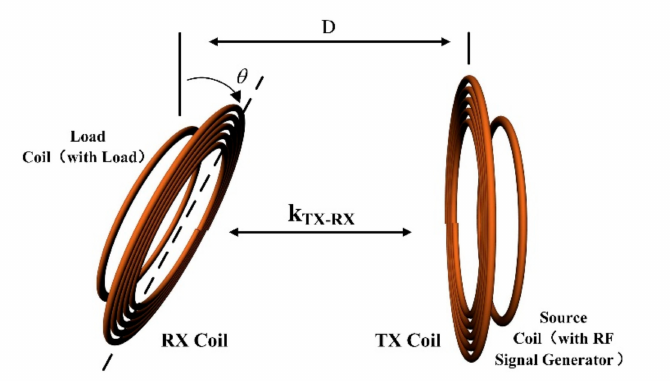
Figure 1. Schematic of wireless power transfer (WPT) system.